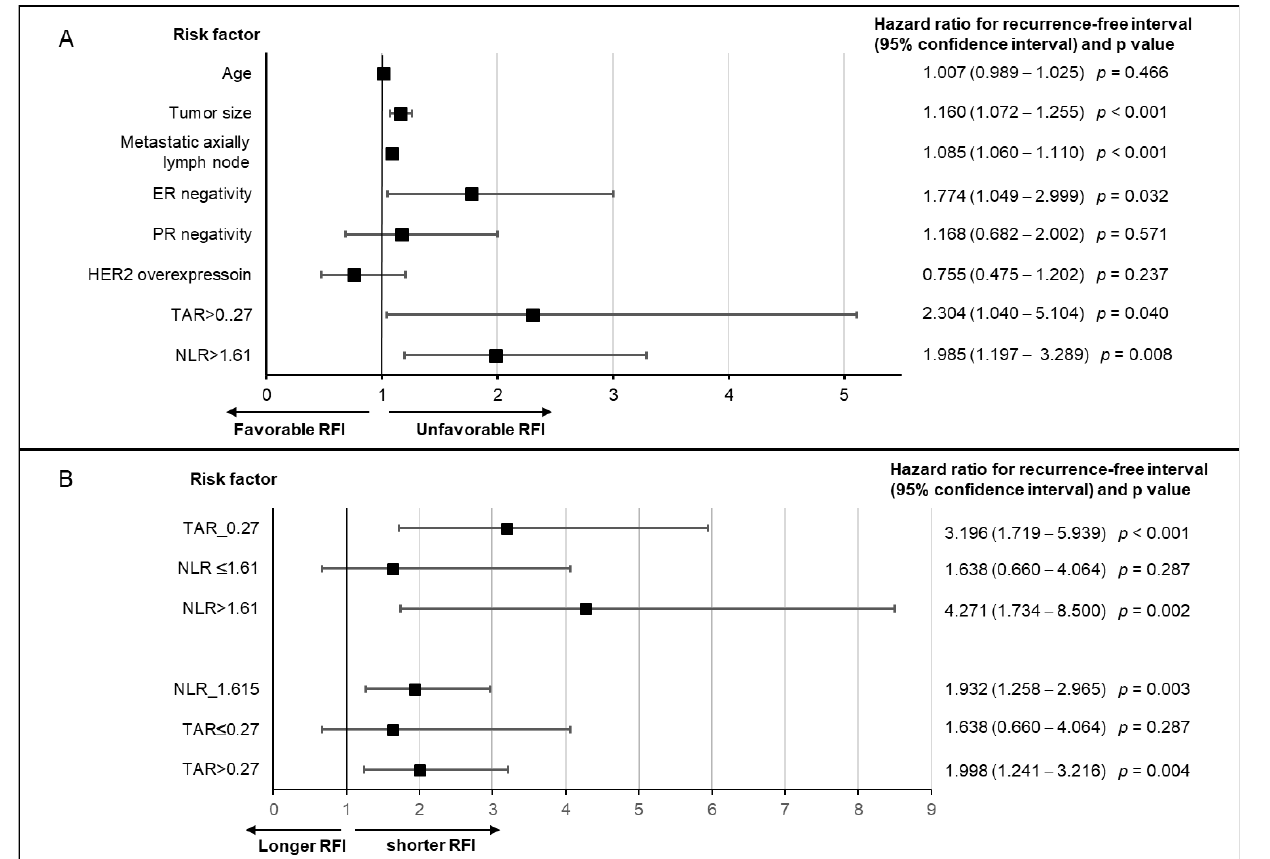
Figure 3. Effect of clinical factors, the tumor-to-aorta ratio of Hounsfield units on contrast-enhanced computed tomography (TAR), and the serum neutrophil-to-lymphocyte ratio (NLR) on recurrence- free interval (RFI).( A ) Forest plot A shows the hazard ratios (HRs) and 95% confidence intervals (CI) of age, tumor size, metastatic axillary lymph node, estrogen receptor (ER) negativity, progesterone receptor (PR) negativity, human epidermal receptor 2 (HER2) overexpression, TAR > 0.27, and NLR > 1.61 of RFI. The multivariate analysis with a Cox proportional hazard model showed that age, tumor size, the existence of metastatic disease at the axillary lymph nodes, ER negativity, TAR > 0.27, and NLR > 1.61 were independent risk factors for RFI. ( B ) Forest plot B indicates that patients with high TAR > 0.27 and NLR > 1.61 had a significant disadvantage of RFI only when they had a high value of the other factor.